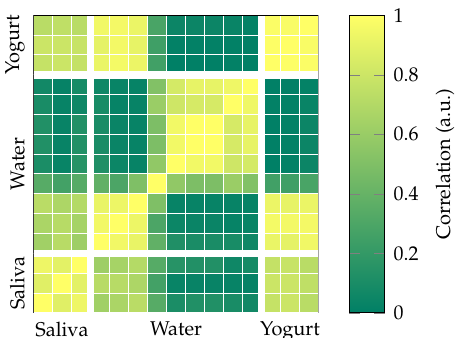
Figure 10. Normalized cross-correlation for both experiments with Subject “b”